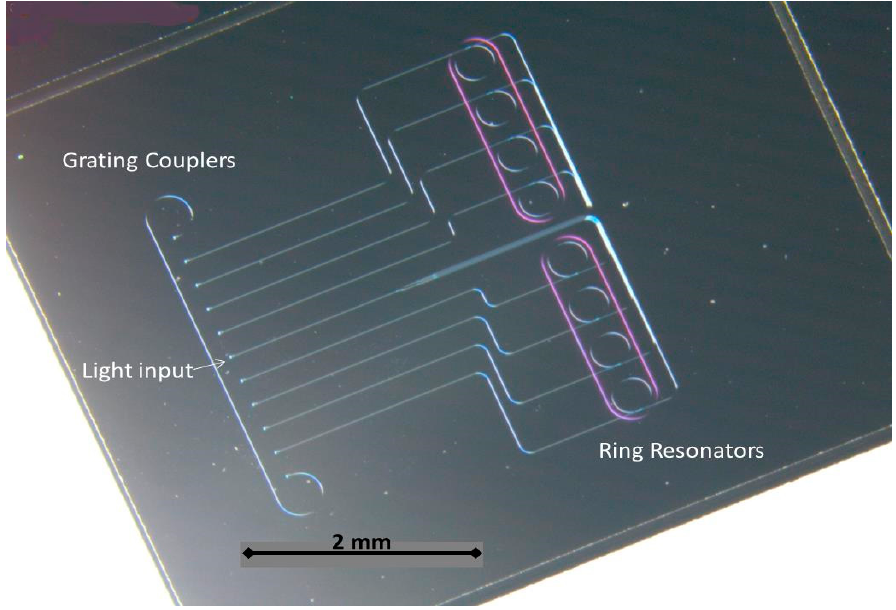
Figure 2. Real fabricated biosensor PIC (image obtained by optical microscope).